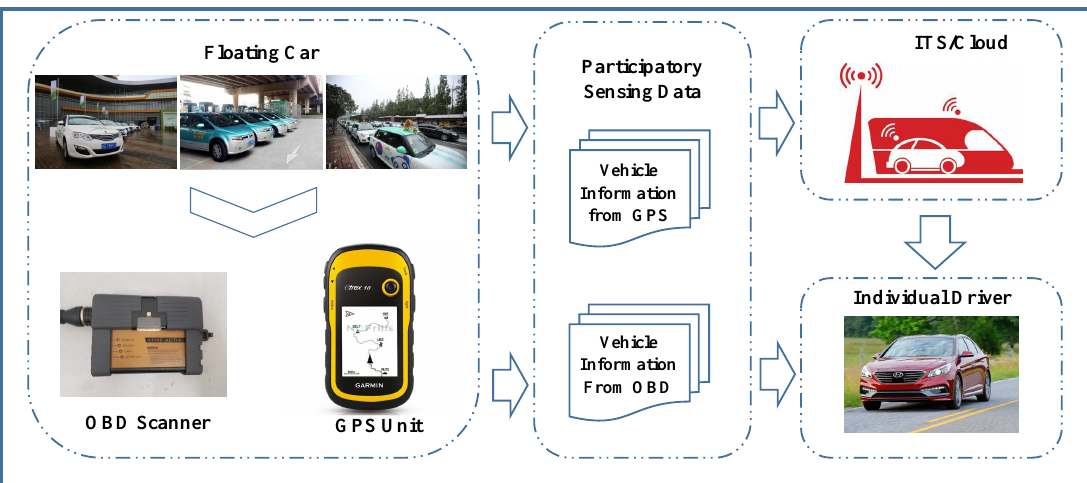
Figure 5. Process of traffic data collection. ITS; intelligent transport